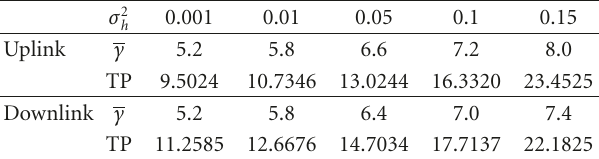
Table 7: Total transmit power (TP) for uniform terminal distribu- tion, γ ∗ = 5. Table 8: Total transmit power (TP) for nonuniform terminal dis- tribution, γ ∗ =